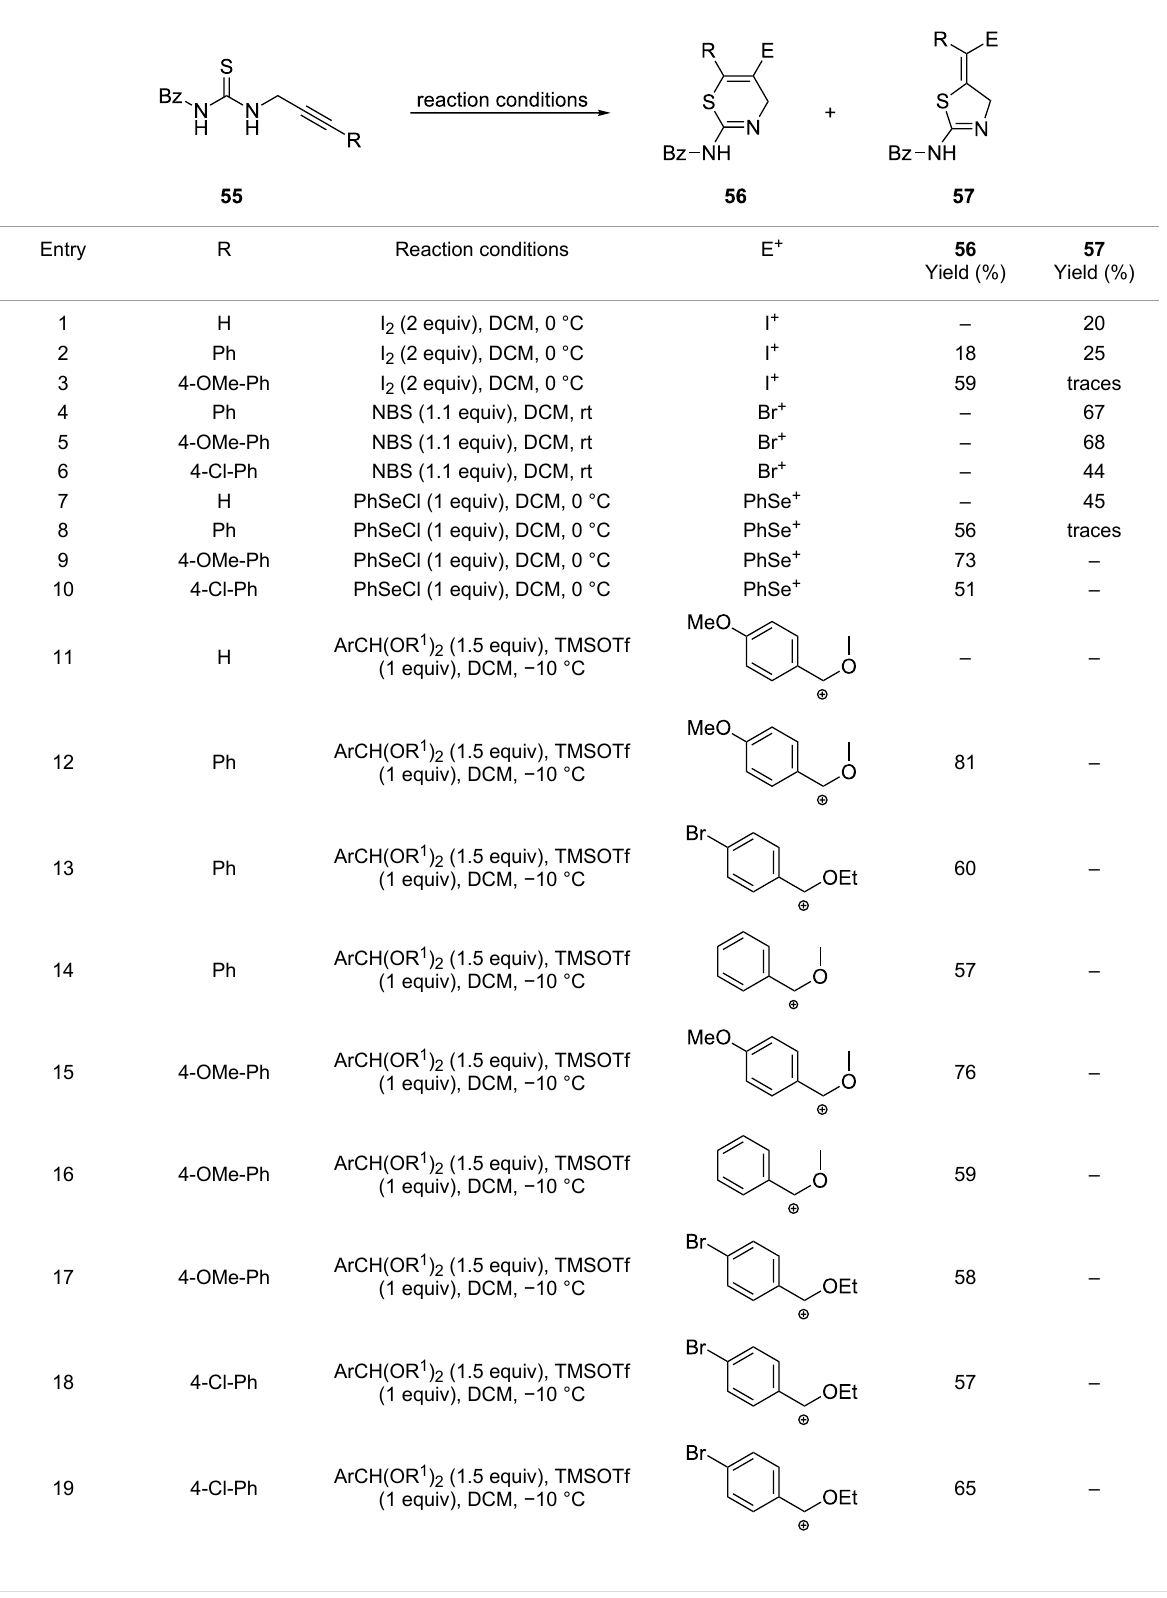
Table 2: Electrophile-mediated cyclization of N -propargylthioureas 55